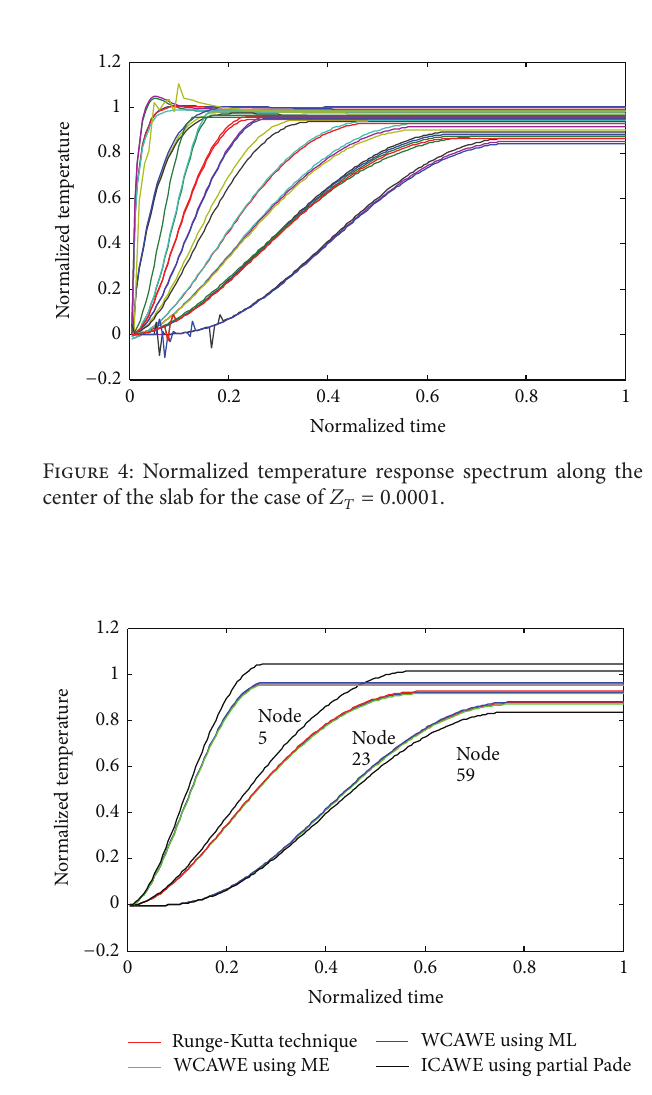
Figure 5: Comparison with TWCAWE-ML, TWCAWE-ME, Runge-Kutta technique, and AWE using partial Pade in the case of = 0.05 𝑍 𝑇